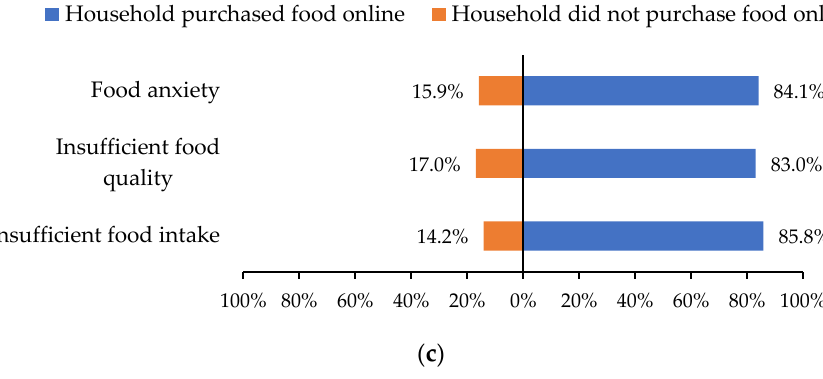
Figure 2. Distribution of online food purchase in relation to three different aspects of household food insecurity: ( a ) prevalence of household food anxiety, food quality, and food intake; ( b ) online food purchase by households with adequate food quality and intake and no anxiety about food supply; and ( c ) online food purchase by households with insufficient food quality and intake and with anxiety about food supply. Source: Authors’ own compilation.